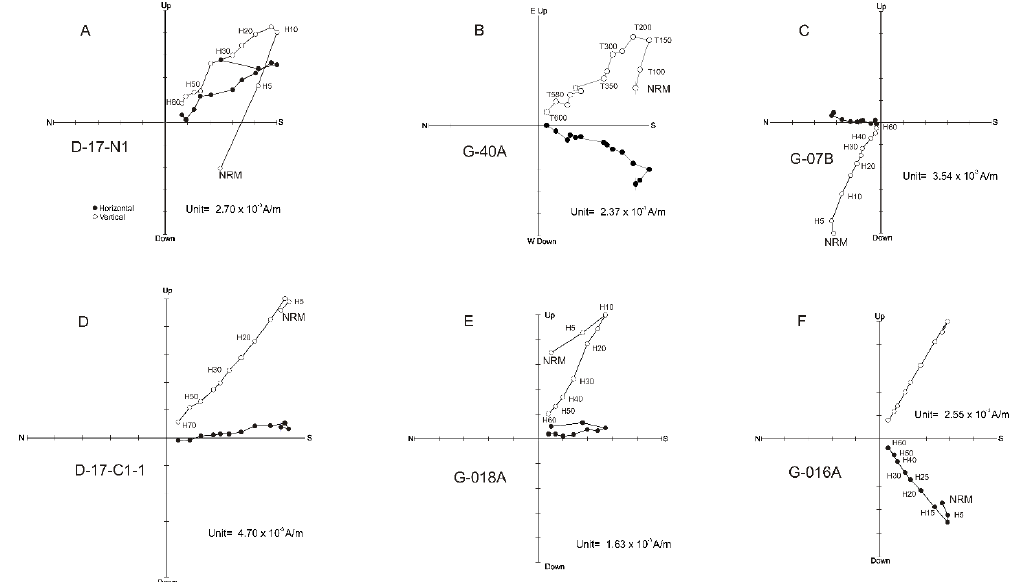
Figure 4. Orthogonal vector plots of alternating field (AF) and thermal (TH) demagnetization of representative samples ( A – F ) of Dafnero sections. Solid circles indicate horizontal component; open circles indicate vertical component. Demagnetization steps in mT or °C. NRM is the natural remanent magnetization.